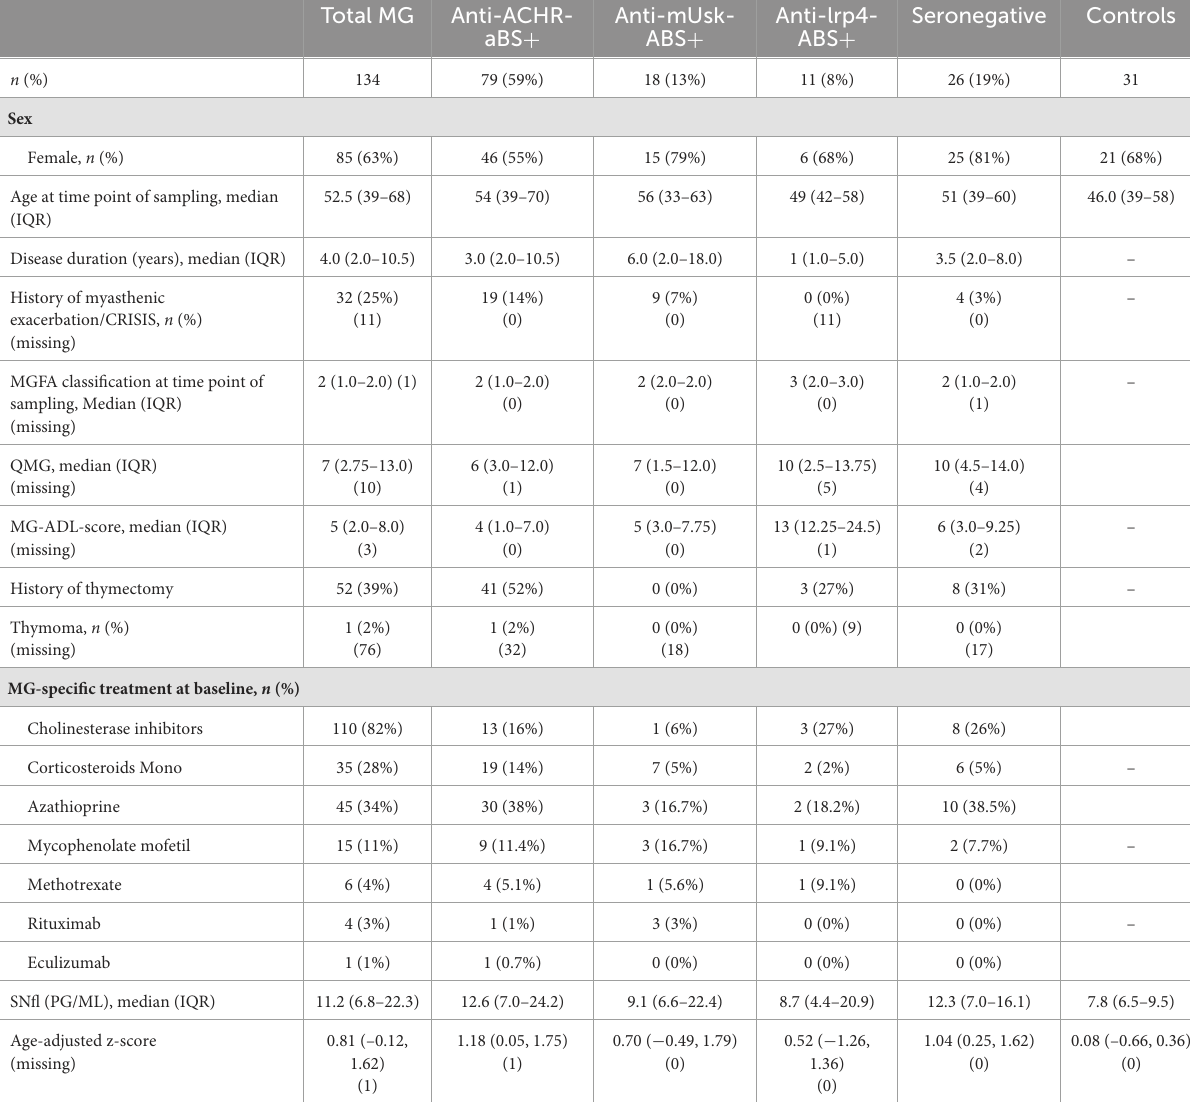
TABLE 1 Baseline characteristics and medical history of patients with myasthenia gravis and controls.